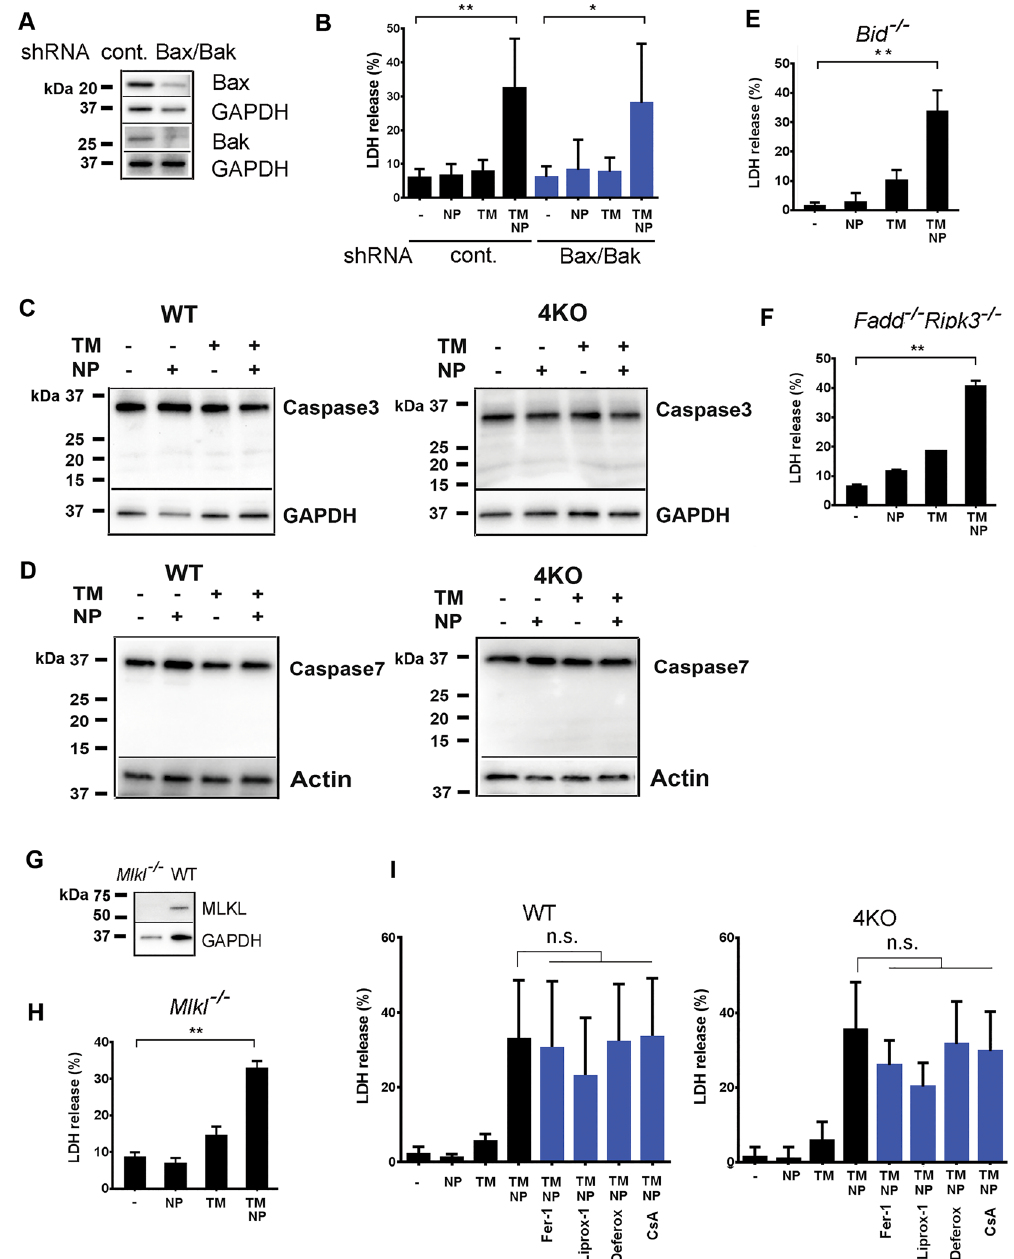
Figure 2. Synthetic nanoparticles trigger death of Mϕs in vitro independently of key regulators of cell death. (A) and (B) —BAX and BAK expression were knocked down by lentiviral shRNA stable-transduction in BMDM from 4KO mice. ShRNA knockdown efficacy was determined by Western Blotting (A) and BMDM death upon TM and nanoparticle treatment was determined by LDH release in the culture media (B) N = 5. ** P = 0.0043; * P = 0.0258. (C) Caspase 3 activation in WT and 4KO BMDM was analyzed after TM and NP treatment by Western blotting. N = 4–5. (D) Caspase 7 activation in WT and 4KO BMDM was analyzed after TM and NP treatment by Western blotting. N = 2–3. (E) BMDM death from Bid -/- mice were assessed by LDH activity release in the culture media, N = 3. ** P = 0.0017 (F) BMDM death from Fadd -/- Ripk3 -/- mice was determined by LDH activity release in the culture media, N = 2, ** P = 0.0018. (G) Western Blotting analysis shows lack of MLKL expression in Mlkl -/- mice. N = 2. (H) BMDM death from Mlkl -/- mice was assessed by LDH activity in the culture media, N = 2; P = 0.0055. (I) Effects of chemical inhibitors of known necrotic death pathways on necrotic death of WT and 4KO BMDM after TM and NP treatment were analyzed by measuring LDH activity in the culture media. N = 3. n.s.–not statistically